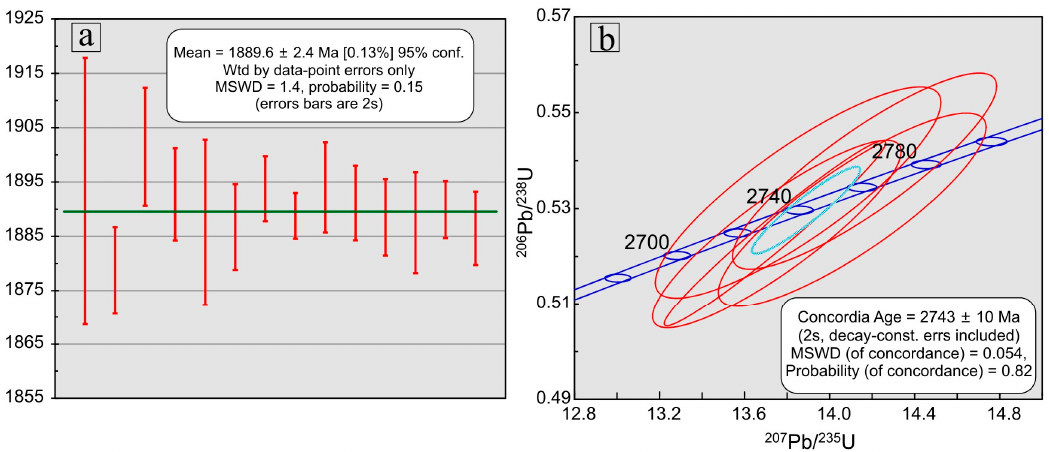
Figure 6. ( a ) Weighted mean 207 Pb / 206 Pb age (Ma) for dark-CL pegmatitic zircons (main population); ( b ) concordia plot for zircons with sectorial (mosaic) in CL zoning.